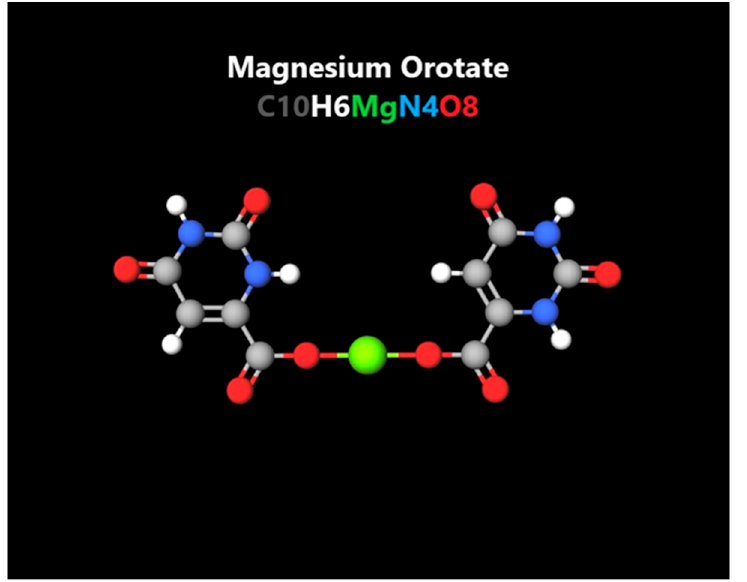
Figure 2. Molecular aspect of magnesium orotate (created with www.molview.org accessed on 27.03.2022).